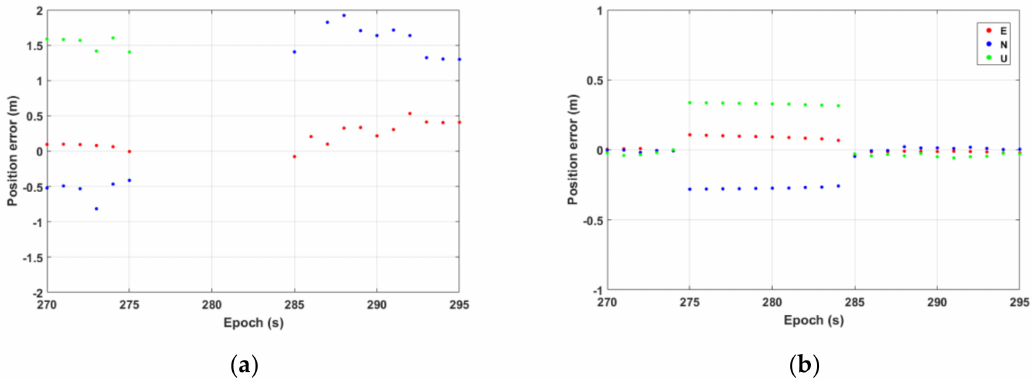
Figure 8. Position errors in the E, N, and U components from 270 s to 295 s in experiment A. ( a ) PPP − RTK. ( b ) TC PPP −